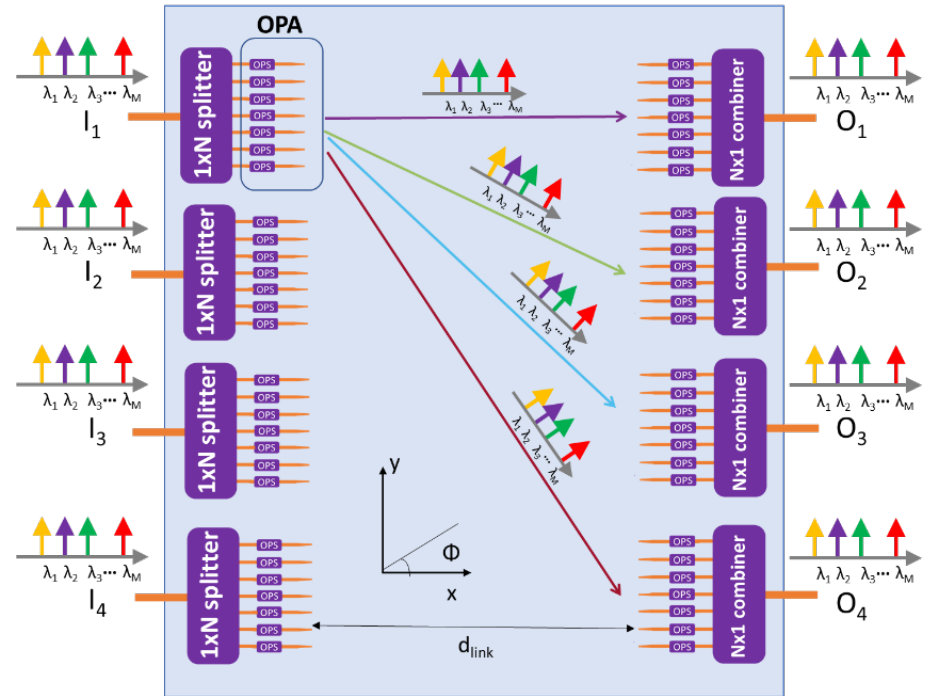
Figure 1. Scheme of the 4 × 4 Optical Wireless Switch (OWS), which connects four-input with four-output Optical Phased Arrays (OPAs). The signal in each of the seven antennas in the OPAs is suitably phase-shifted by Optical Phase Shifters (OPSs) to guarantee beam steering.